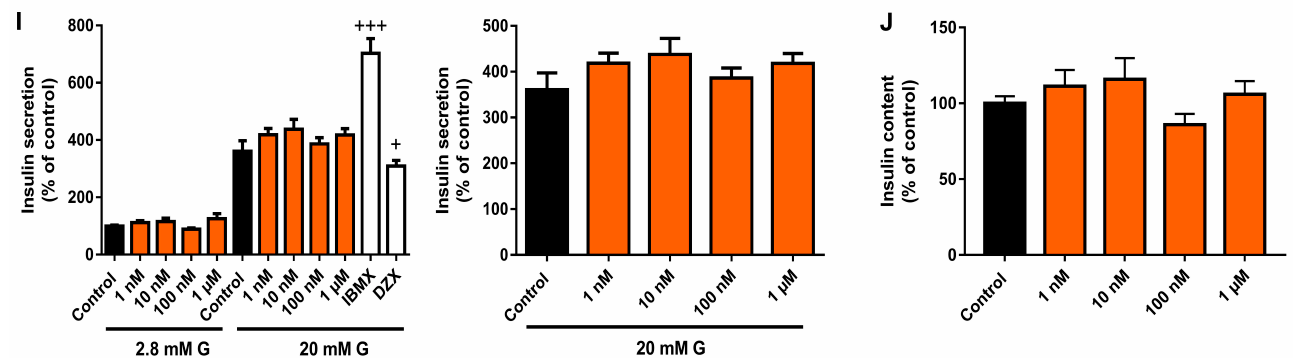
Figure 6. DDE effects on pancreatic β -cells . ( A ) Viability of MIN6 cells treated for 24 h with